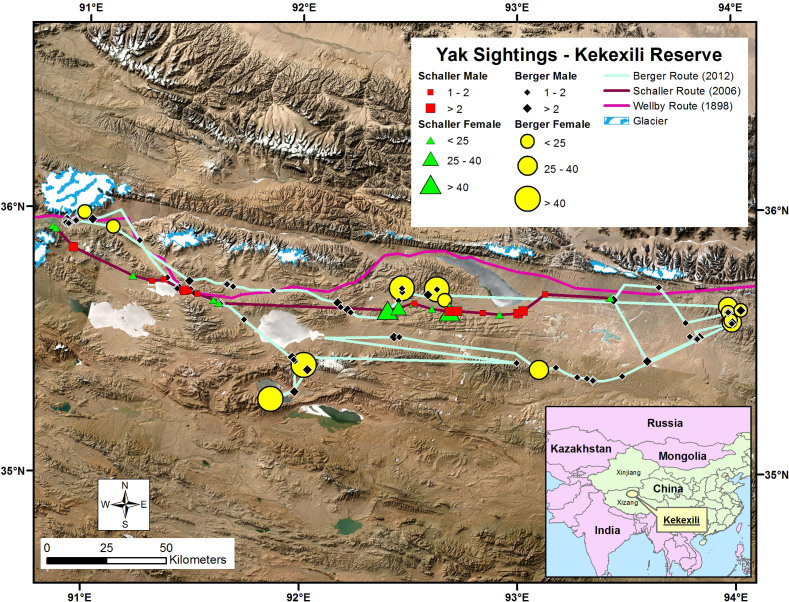
Distribution of yaks by group size and sex in relation to 22 glaciers in western China.Welby's 1896 travel and 2006 and 2012 survey routes shown, the latter two from which Resource Selection was estimated by covariates in Table 2. The map is modified from Berger15 and with permission from Allen Press and first published by Oxford University Press, and created from ArcGIS Desktop (version 10.0), with spatial metrics projected to WGS 1984 (UTM) Zone 46 North81. Landsat Global Land Survey (GLS) Shaded Basemaps and natural color, 15-m resolution pan-sharpened Landsat images, enhanced with topographic hill-shading and color balancing with U.S. Geological Survey and the National Aeronautics and Space Administration Landsat images (http://imagery.arcgisonline.com/arcgis/rest/services/LandsatGLS/LandsatShadedBasemap/ImageServer) were used for mapping purposes.